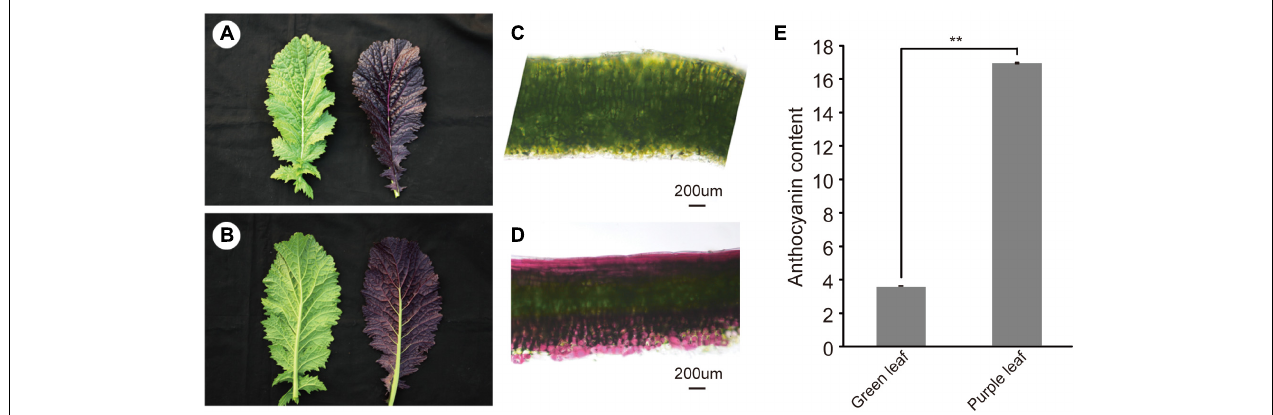
FIGURE 1 | Morphology of purple leaf and anthocyanin content in B. juncea . (A) Upper epidermis of green (LvYi) and purple (ZiYi) leaf. (B) Lower epidermis of green and purple leaf. (C) Transverse section of a green leaf. Bars = 200 µ m. (D) Transverse section of a purple leaf. Bars = 200 µ m. (E) Total anthocyanin contents of green and purple leaves. **Signifcantly diferent at P <